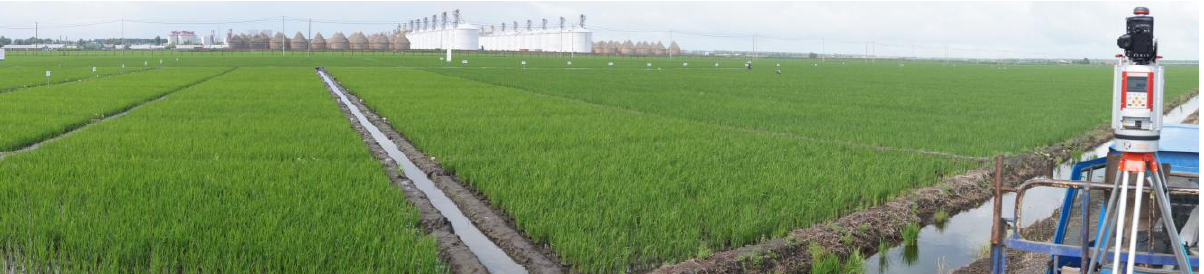
Figure 1. Overview of the investigated area from one scan position at the south edge of the field. On the right side the scanner with the tripod mounted on the small trailer can be